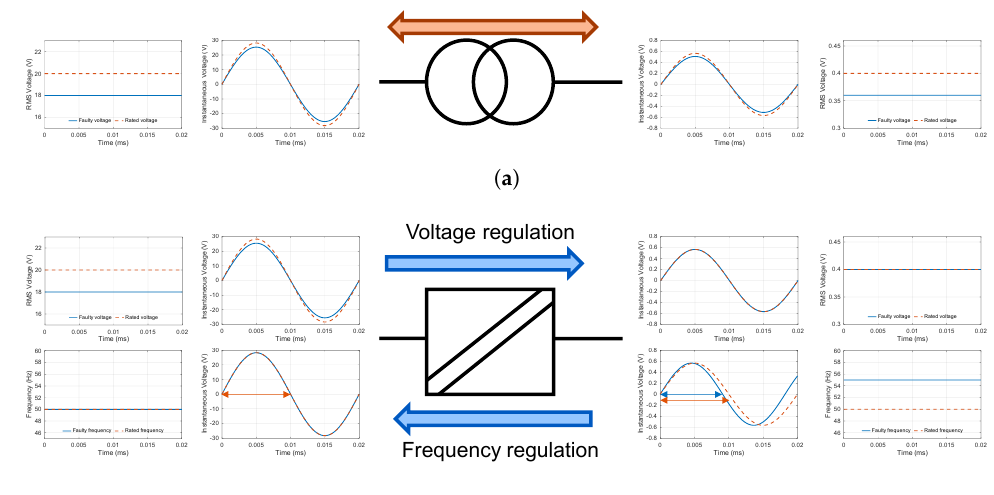
Figure 4. Voltage and frequency regulation feature by a SST device. ( a ) A classic power transformer has the same voltage and frequency deviations in both sides. ( b ) A SST is able to smoothly regulate the output in terms of voltage and frequency magnitudes.